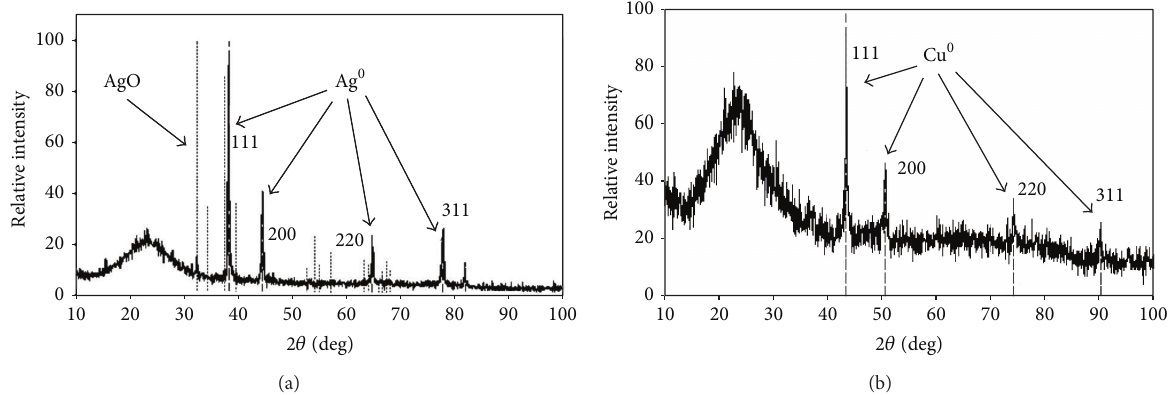
Figure 3: XRD curves of silica containing immobilized nanosilver (a) and nanocopper (b).